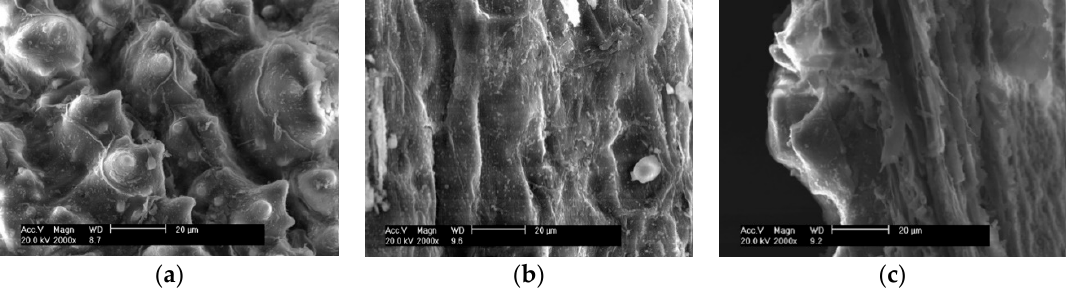
Figure 6. SEM morphologies of ( a ) outside surface, ( b ) inside surface, and ( c ) interlayer of the acid-leached RH.